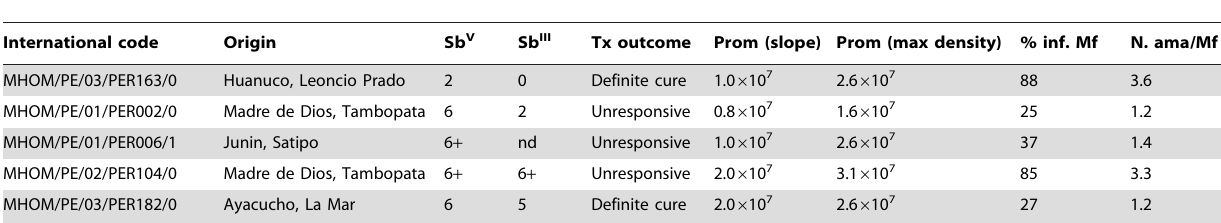
Table 1. Geographical origin and in vitro features of Peruvian L. braziliensis isolates included in the study.